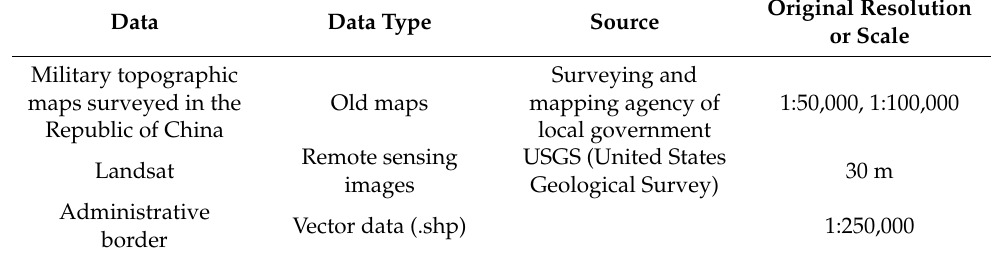
Table 1. Data source overview.